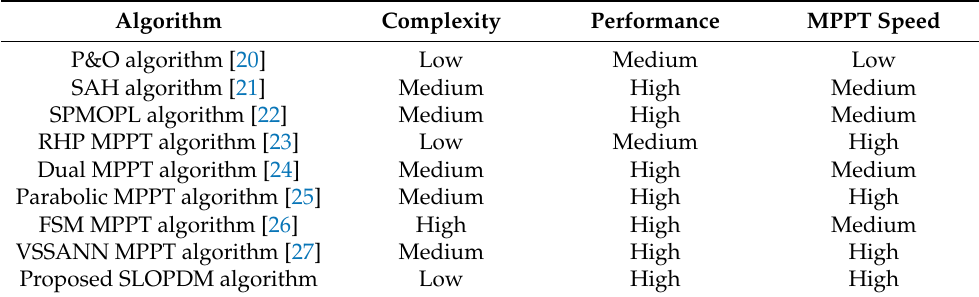
Table 1. Comparison of various MPPT